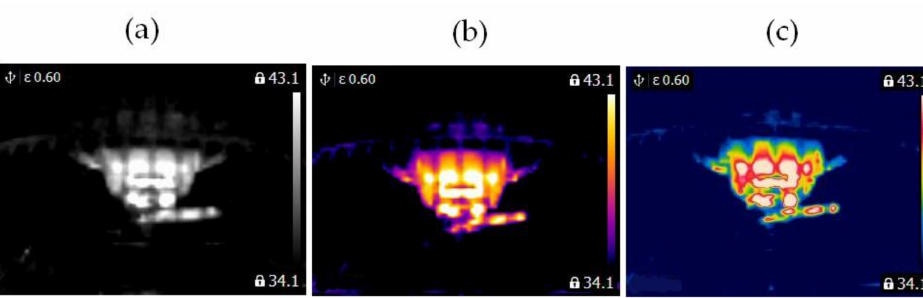
Figure 4. Healthy BLDC motor at 1450 rpm ( a ) gray-scale, ( b ) iron scale, ( c ) rainbow scale.